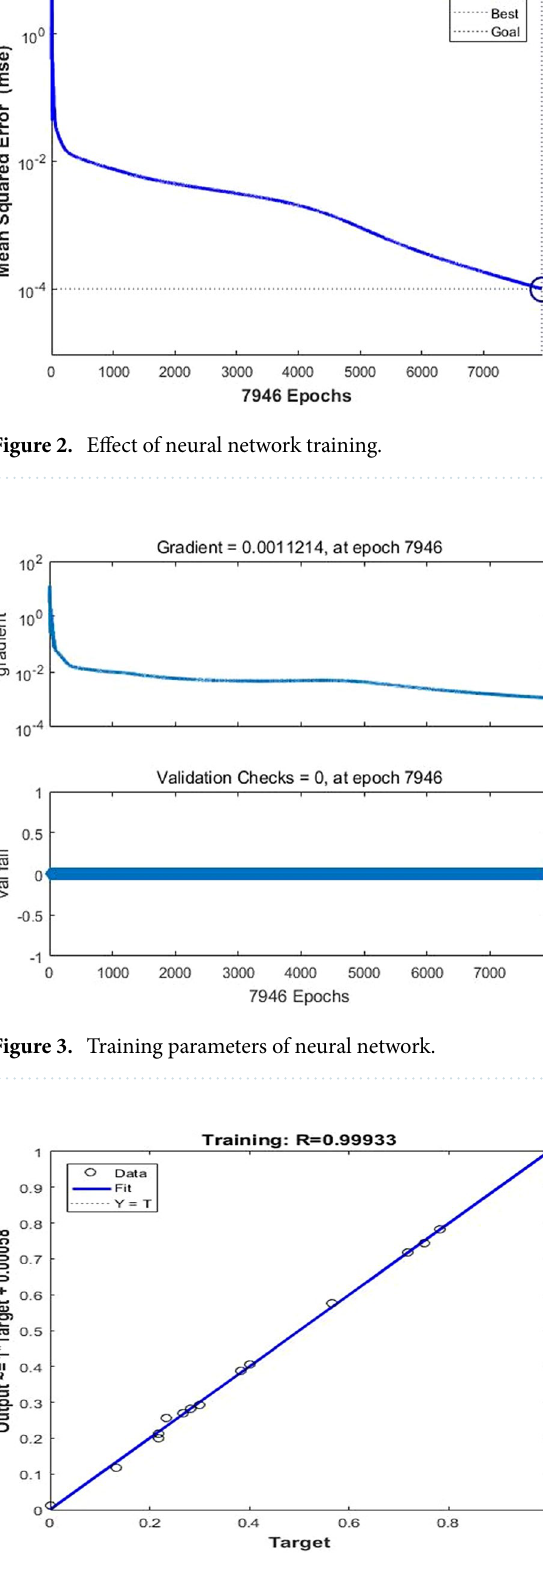
Figure 4. Regression analysis of neural network